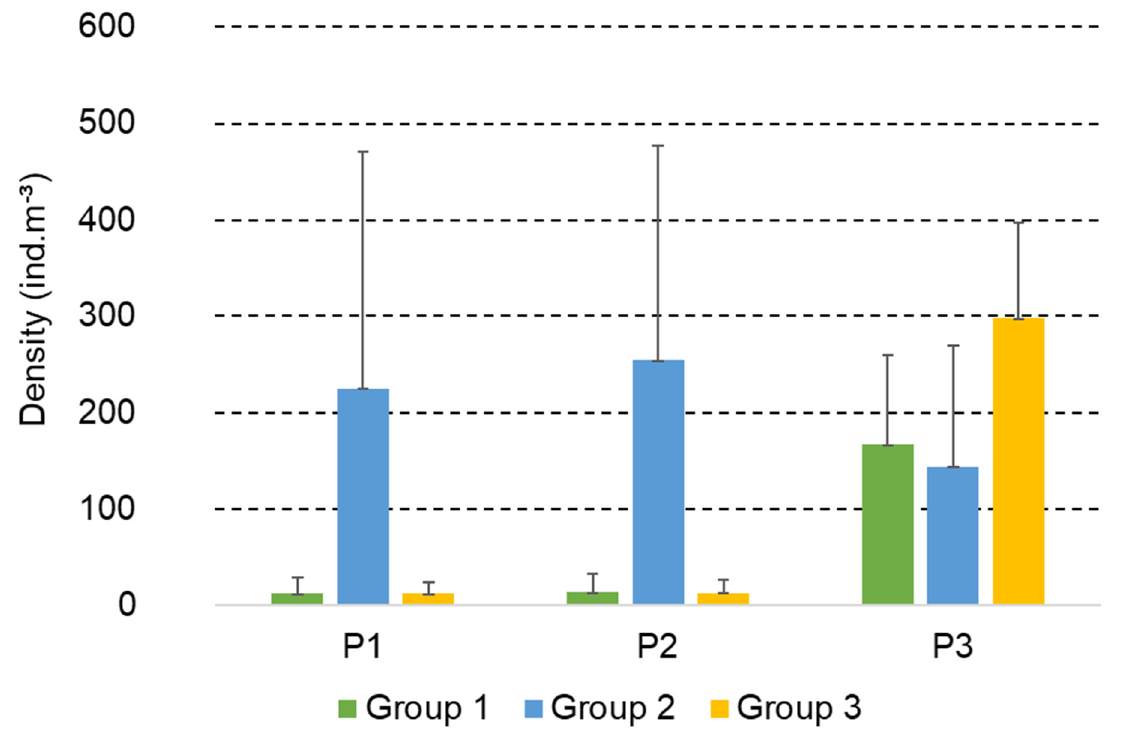
Figure 9. Spatial variation in abundance (ind.m − 3 ) of copepod functional groups in Piranji Estuary (equatorial Southwestern Atlantic, Brazil, 2015).